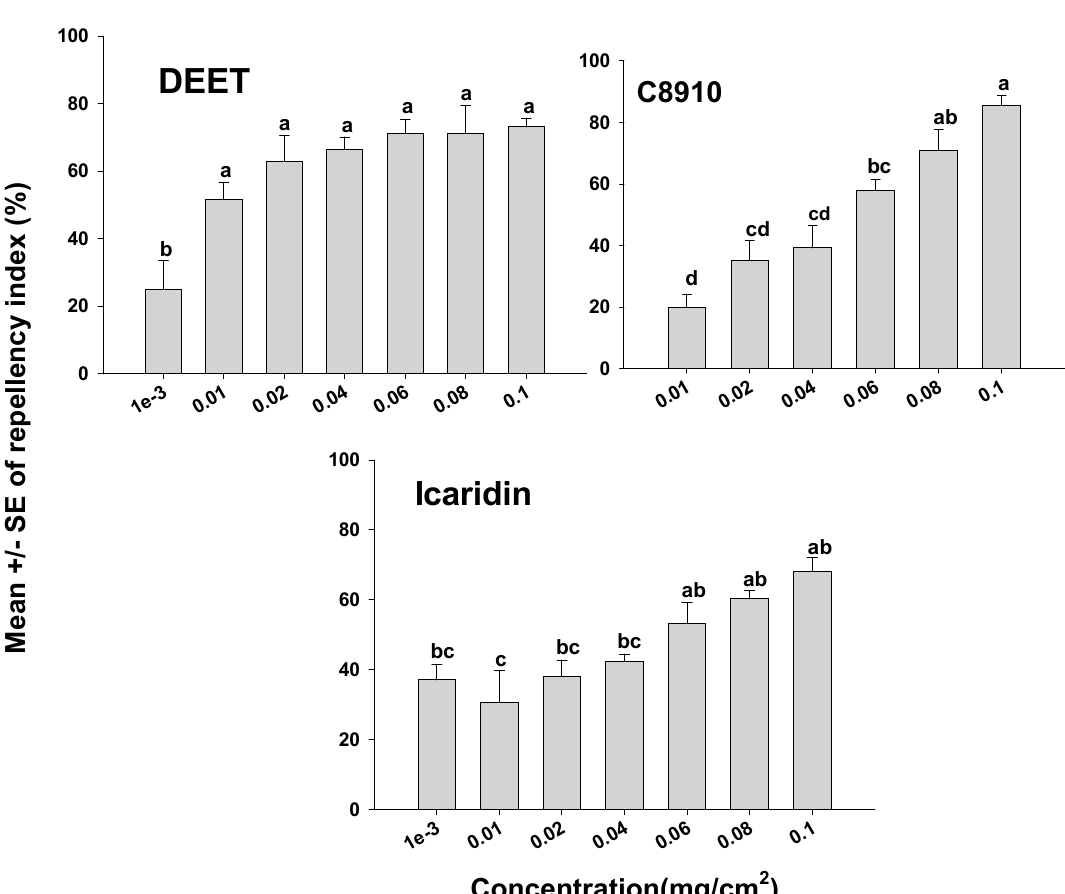
Figure 2. Orientation response of T. putrescentiae on glass surfaces treated with synthetic repellents in a laboratory two-choice behavioral assay. ANOVA determined that there was significant variation among concentrations for each of the compounds tested (F-value ranged from 6.12 to 19.25 and p -value ranging from < 0.01 to 0.03). Mean (± SE; n = 5) RIs for a given repellent with the same letter are not significantly different (REGWQ; p > 0.05).